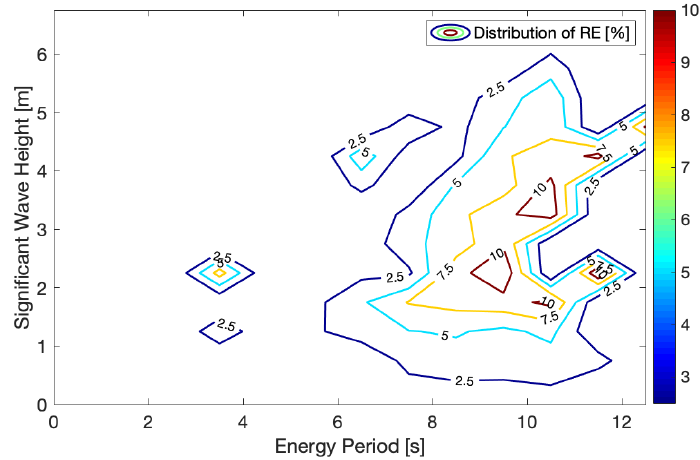
Figure 19. A comparison of the annual energy production at Site 1 between two types of damping control: optimal damping and constant damping with a coefficient of 55 kNs/m (the numbers are presented in hundred percentage). Note that the difference was calculated for each sea state by Equation (9).